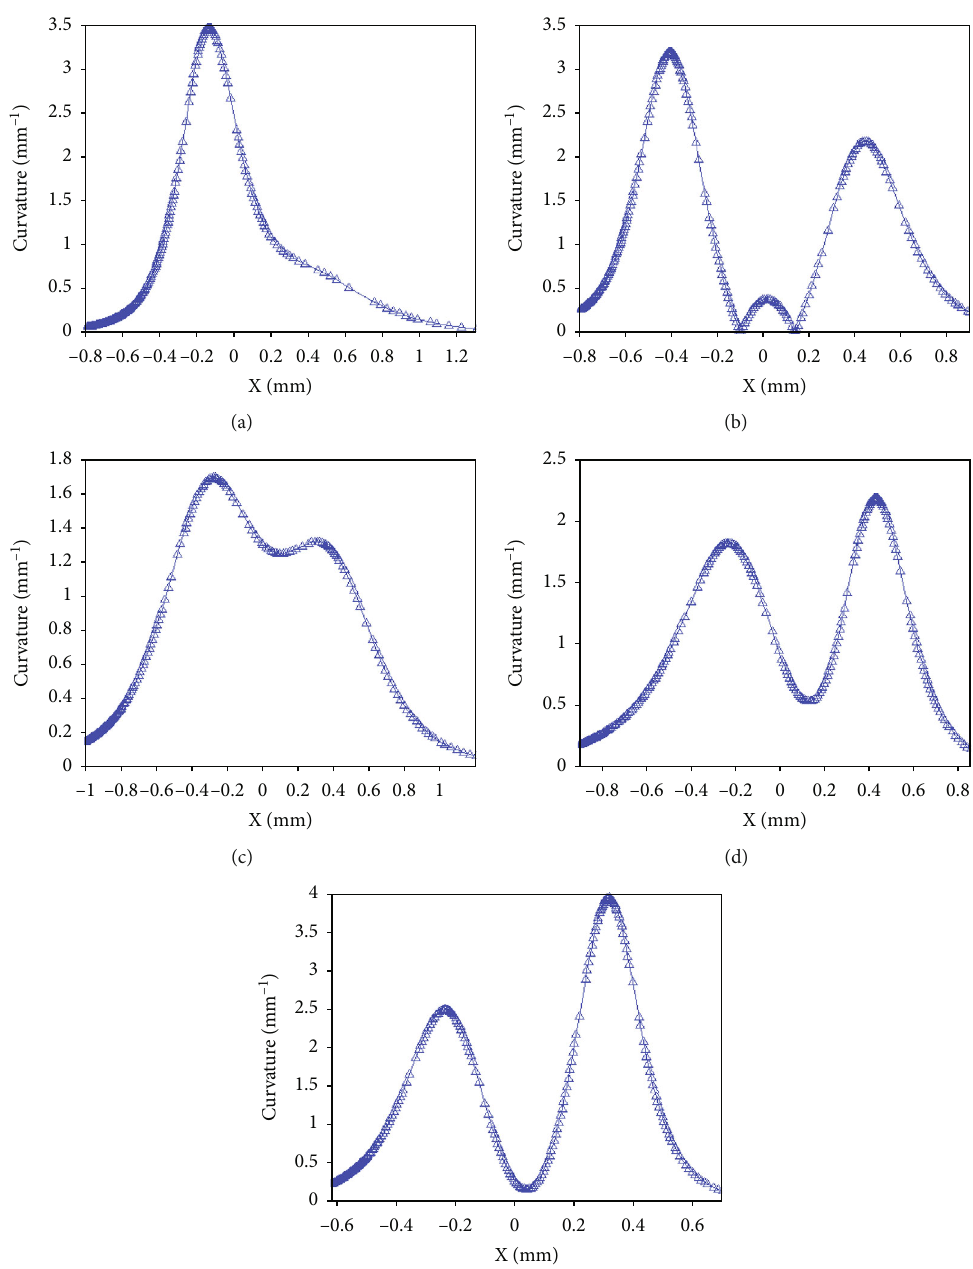
Figure 16: The curvature analysis of the fi tting curves of the fi ve claw tips: (a) the 1st; (b) the 2nd; (c) the 3rd; (d) the 4th; (e) the